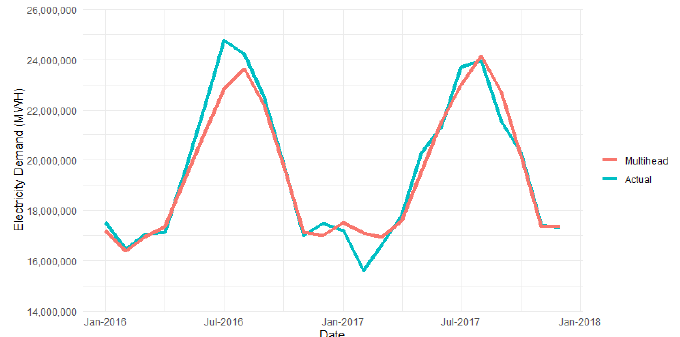
Figure 11. Actual vs. predicted multihead